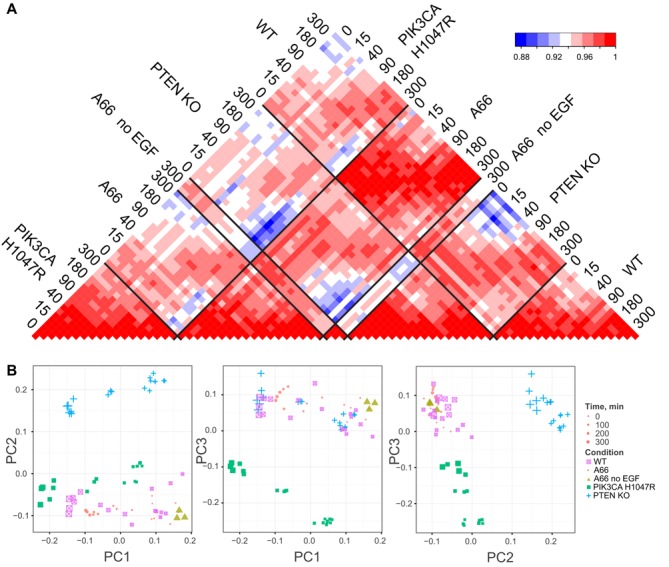
(A) Correlation matrix of all 75 RNA-Seq samples (based on Pearson correlation coefficients). Each labelled row contains three technical replicates; (B) Results of the principal component analysis performed on all 75 RNA-Seq samples. Smaller size of elements corresponds to early time points (0–40 min), large size of elements corresponds to later time points (180–300 min).